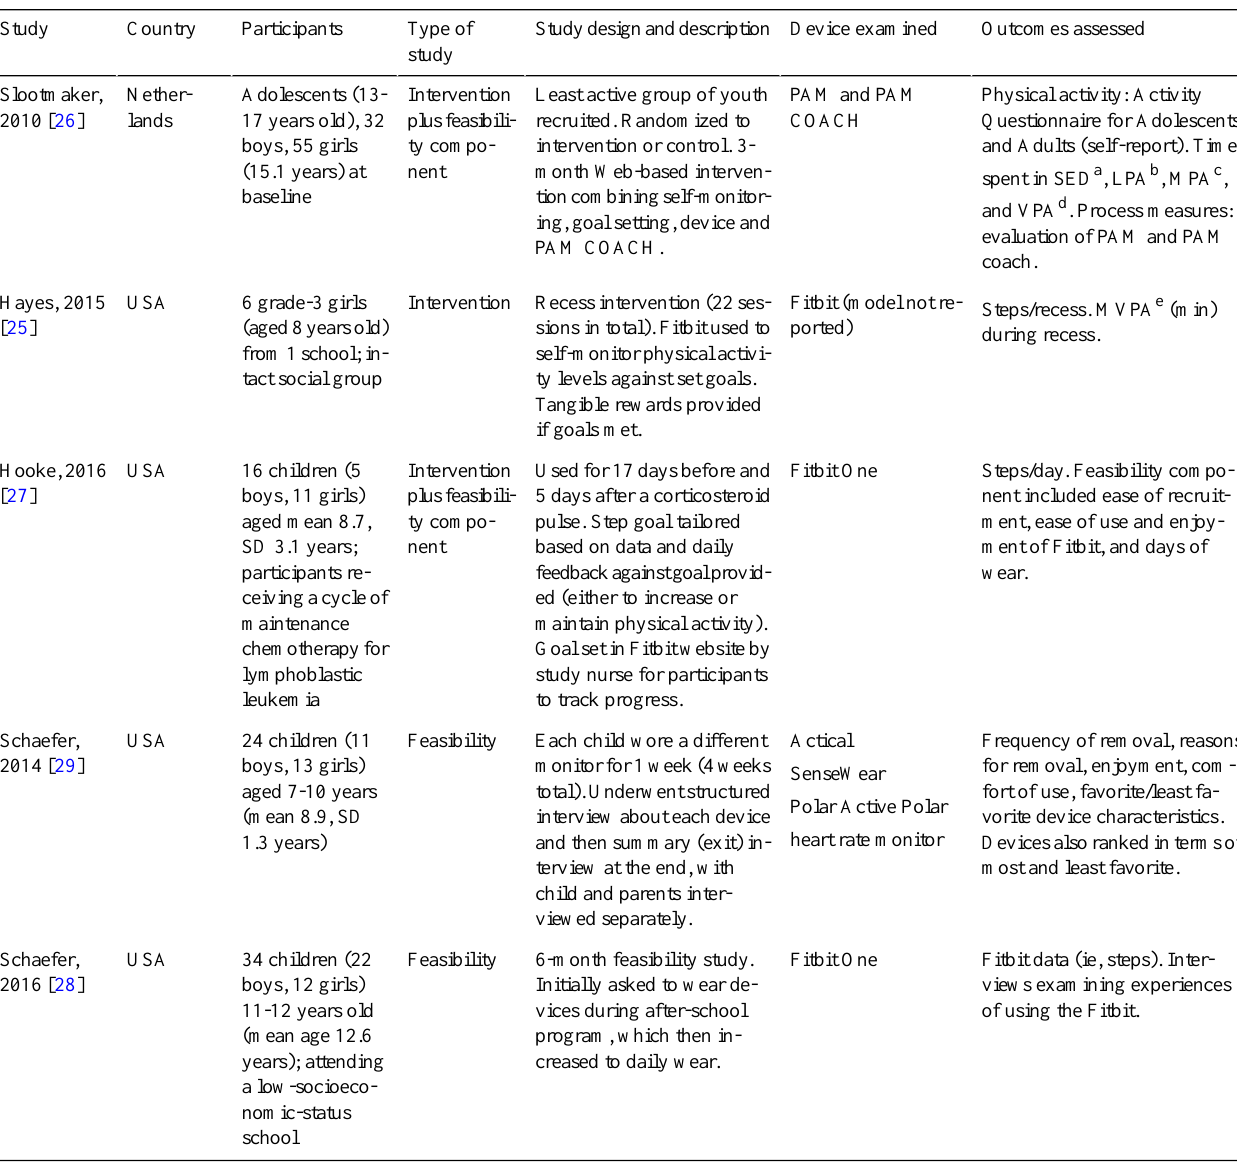
Table 1. Summary of included studies on the effectiveness and feasibility of wearable activity trackers in youth (chronological order by study